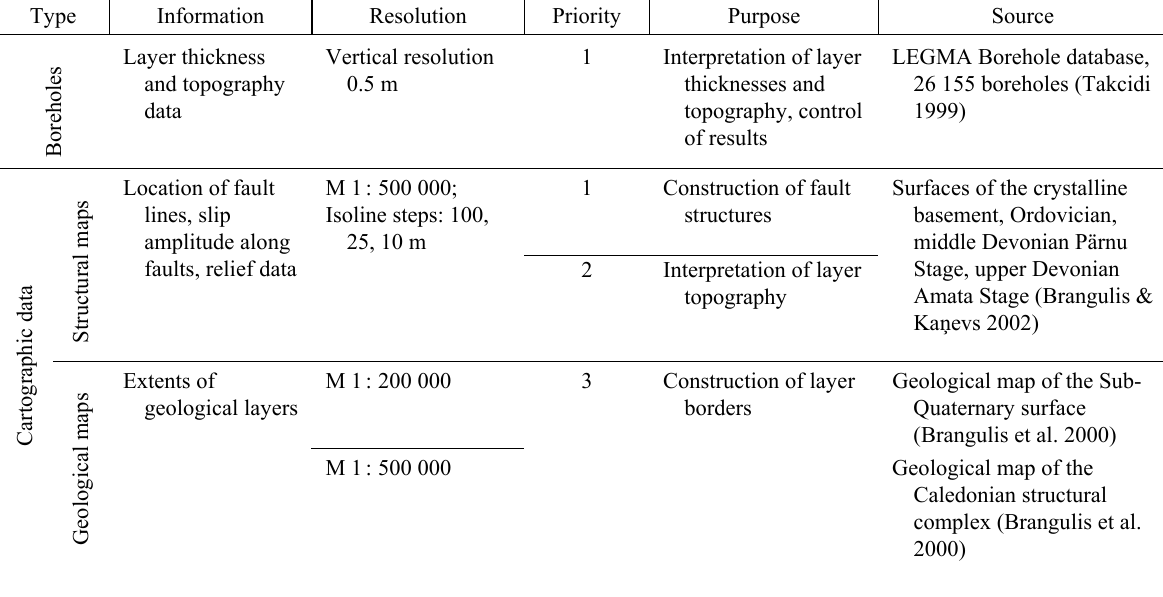
Table 1. Geological data sources, type and usage priority after resolution and purpose in model